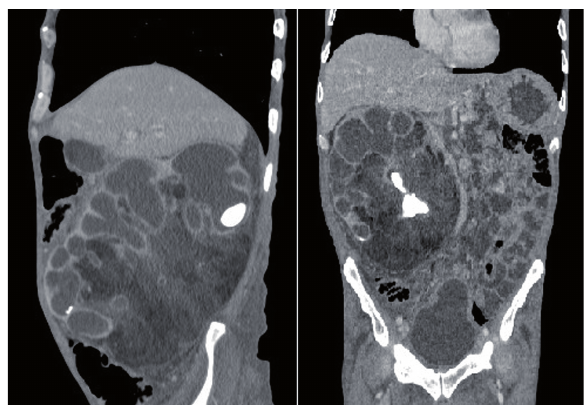
figure 3 - Sagittal and coronal cT images show calculi, dilated calyces and renal parenchymal atrophy and exuberant fibrofatty